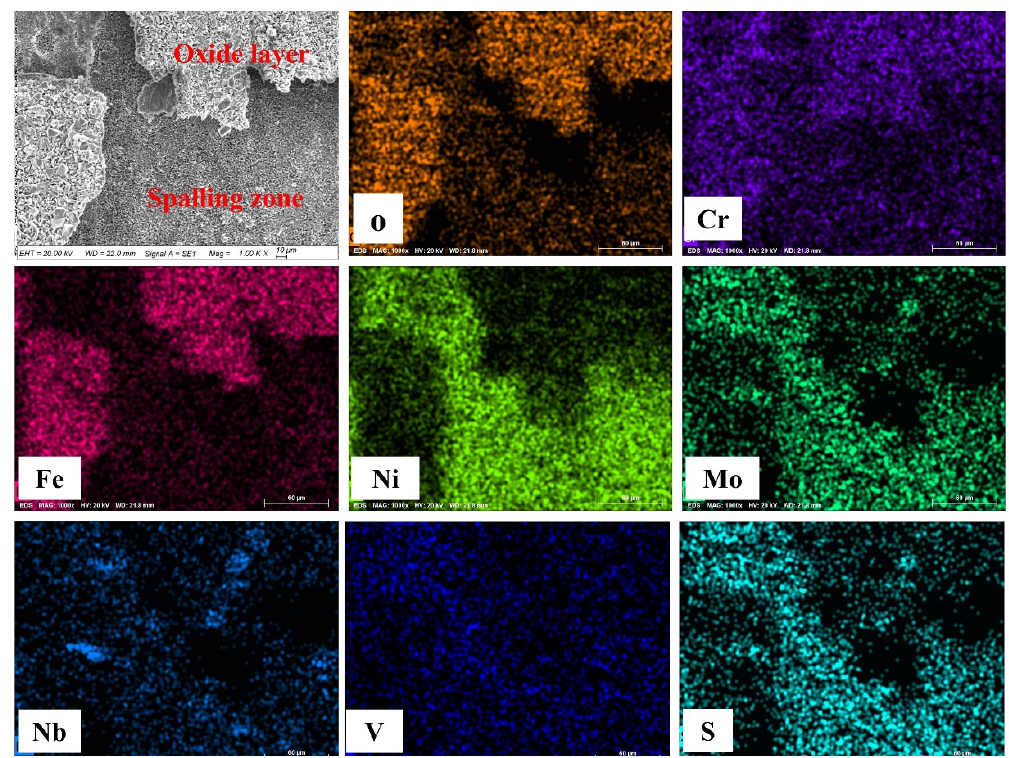
Figure 6. EDS mapping results of the hot corroded sample surface after 100 h test.